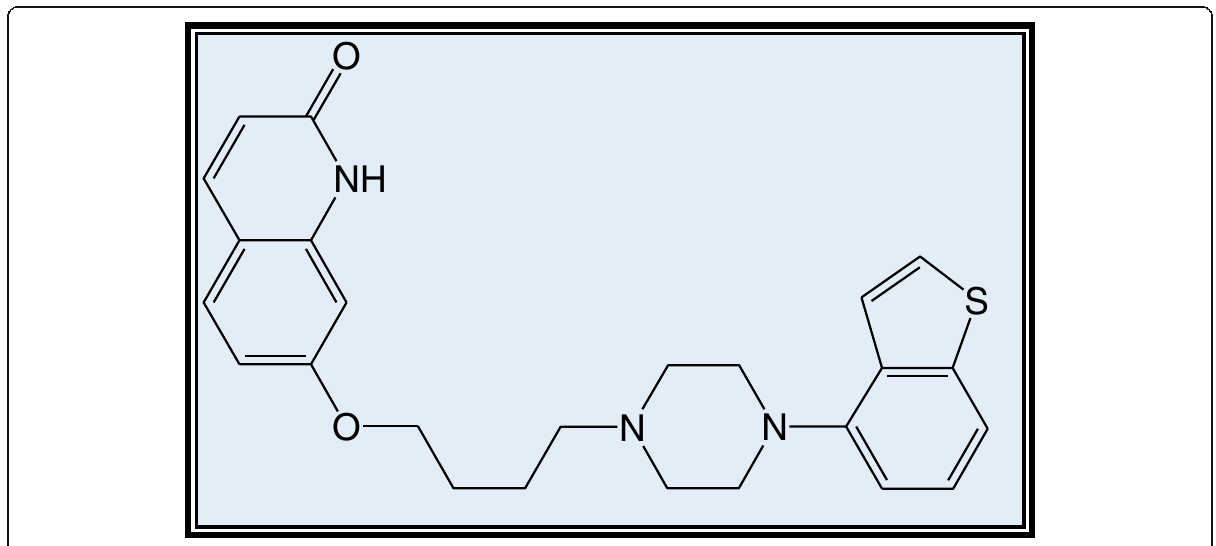
Fig. 1 Molecular structure of brexpiprazole